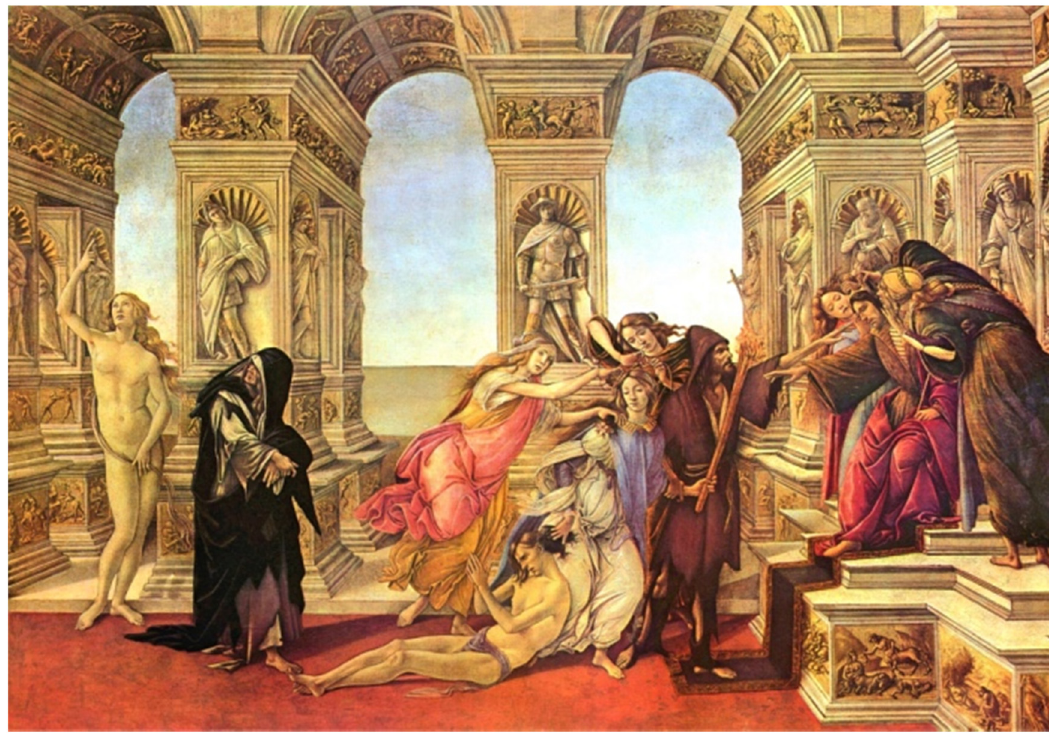
Figure 6: Sandro Botticelli, Calunnia . Ca. 1494. U ffi zi, Florence. Public Domain.